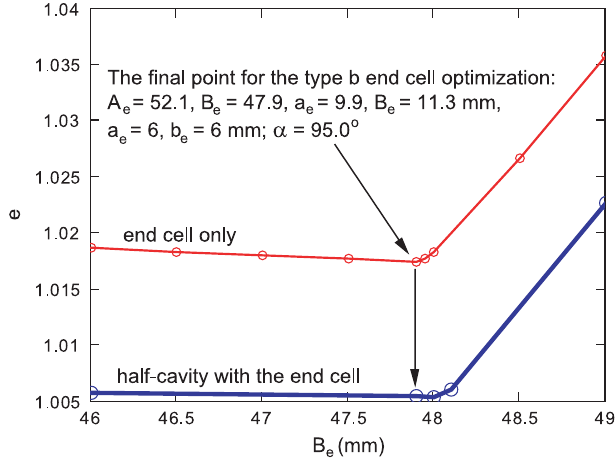
= 2 E acc for the type b end cell alone and pk